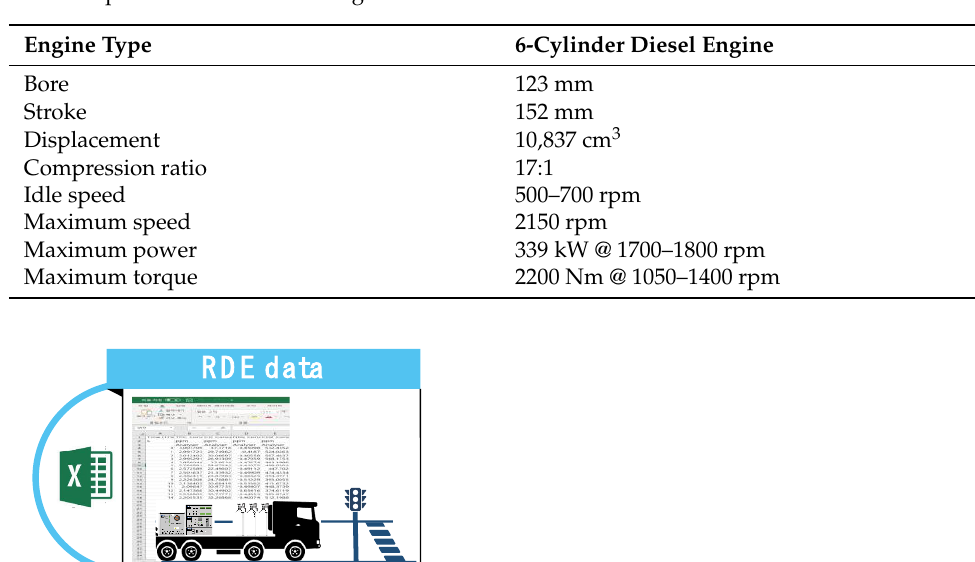
Table 2. Specification of the test engine.